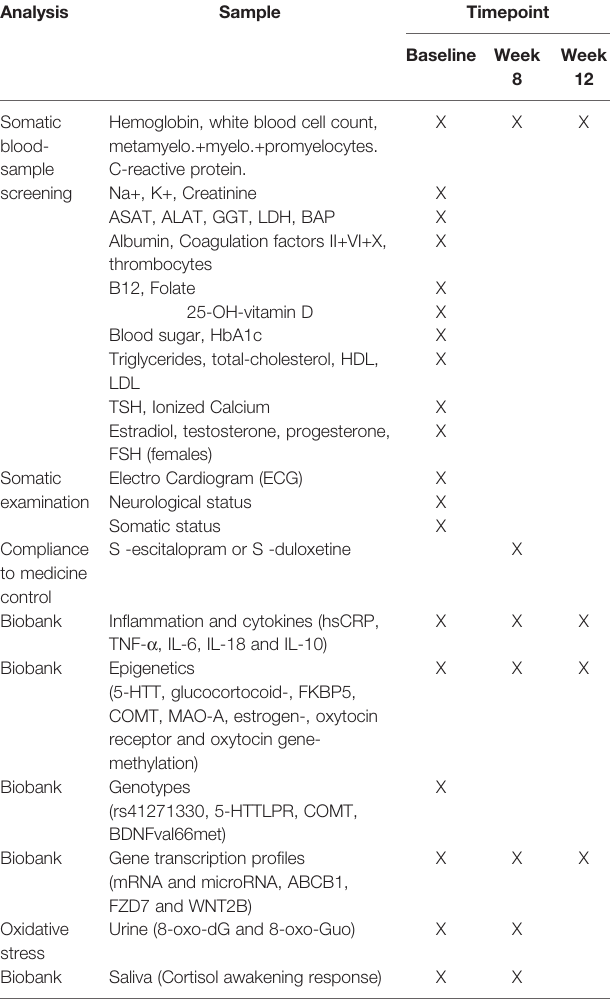
TABLE 2 | Somatic status and biomaterial assessed at various timepoints throughout the study. Analysis